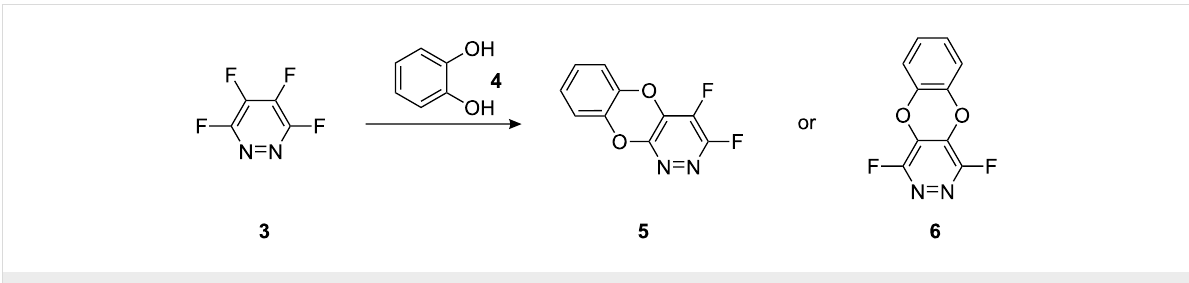
Scheme 2: Synthetic route to dioxa-diaza-anthracene